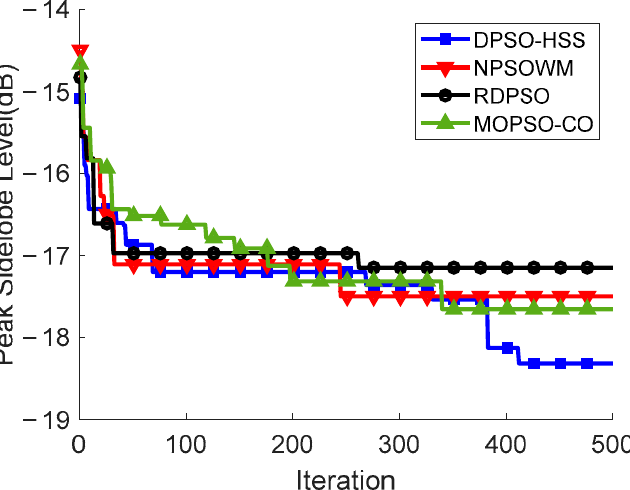
Figure 4. The convergence curve of PSLL using four kinds of algorithms in thinning the 10 λ diam- eter array.